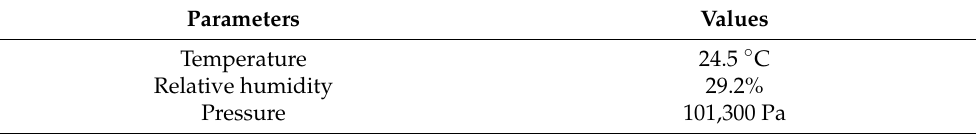
Figure 7. Experimental setup for measuring the TL of a REC. Table 4. Experimental parameters.